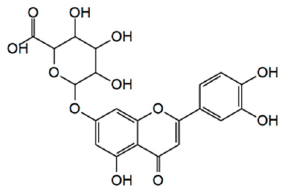
Figure 1. Chemical structure of luteolin-7- O -glucuronide (L7Gn).